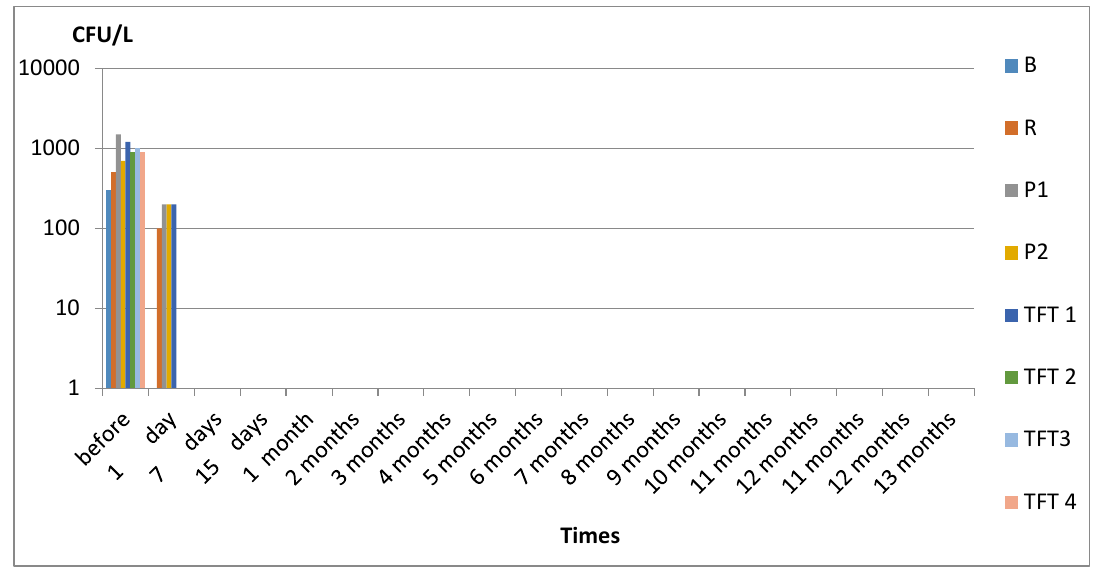
Figure 2. Legionella pneumophila sg1 counts at all the sampling points during the whole period of the study in Hospital 2. (B = boiler; R = recirculation; P1 = point 1; P2 = point 2; TFT1 = time flow tap 1; TFT2 = time flow tap 2; TFT3 = time flow tap 3; TFT4 = time flow tap 4).